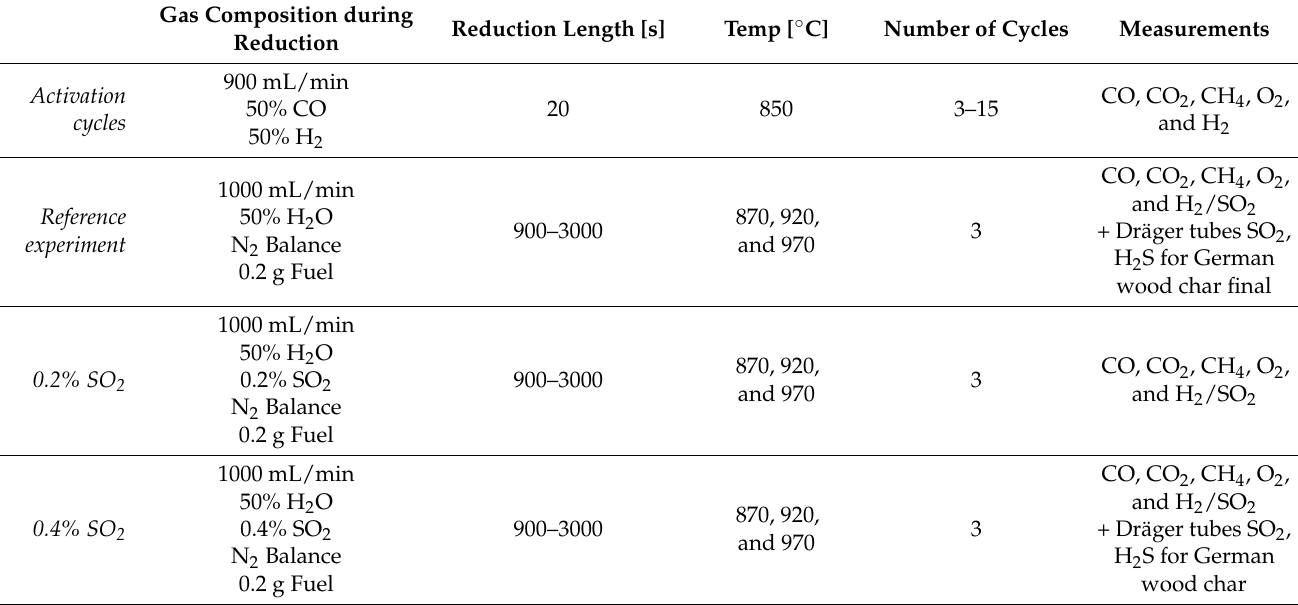
Table 3. Summary of experiments with solid